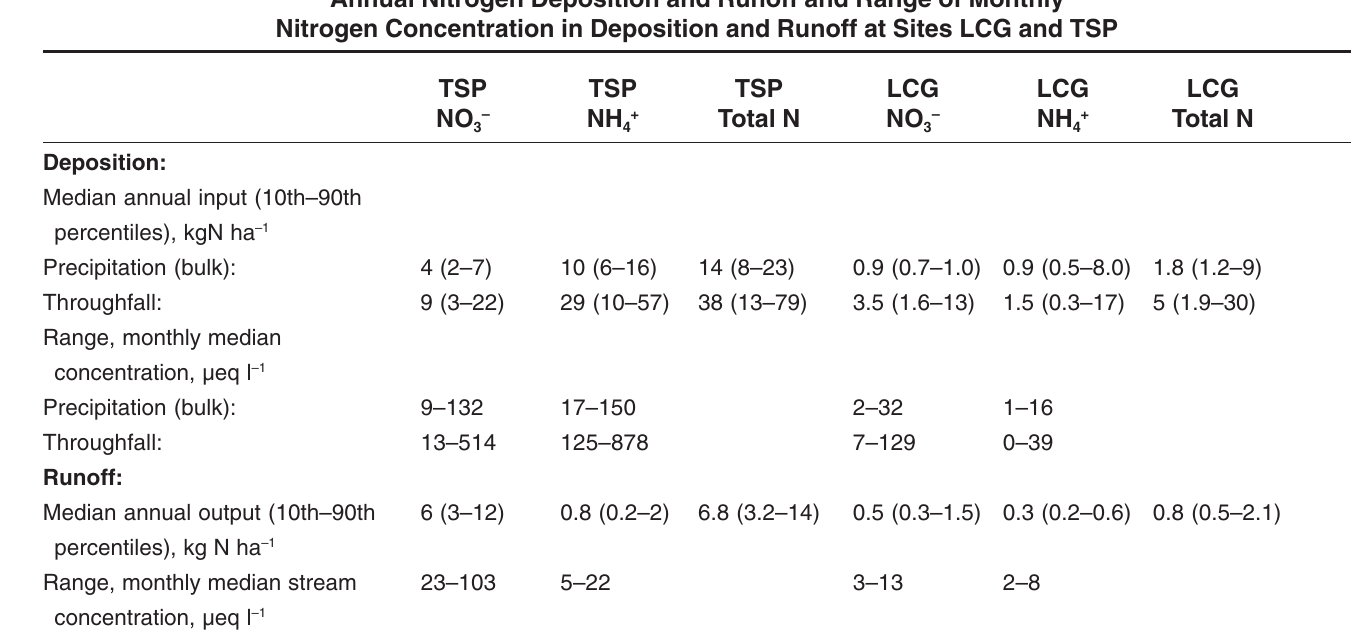
Annual Nitrogen Deposition and Runoff and Range of